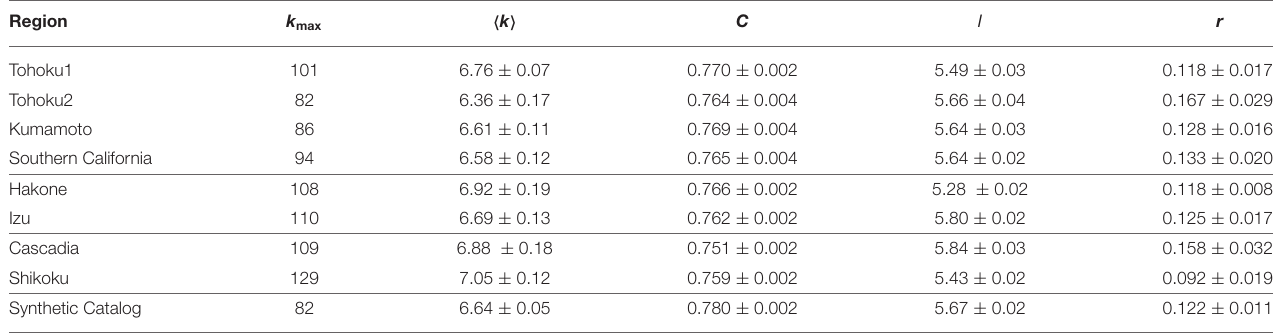
k , clustering coefficient C , shortest path length l , and Pearson correlation coefficient r for the h i 2 12 . =